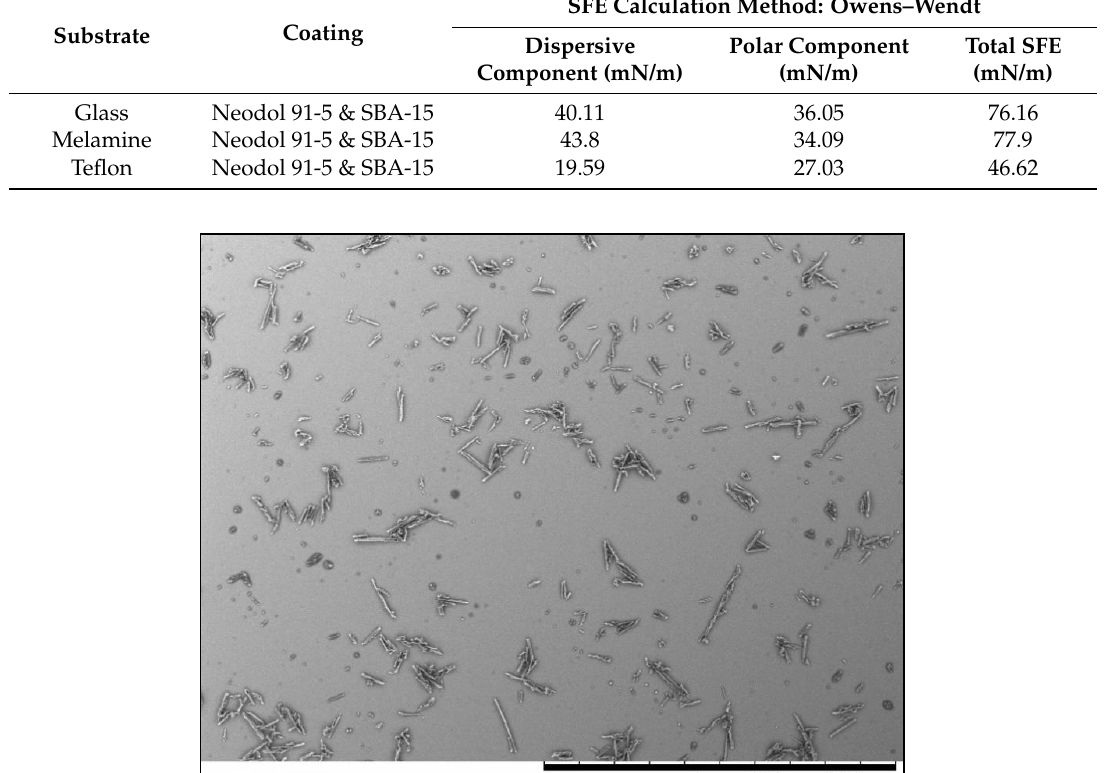
Figure 5. Glass substrate after the modification by the Neodol 91-5 and the SBA-15 solution. Colloids Interfaces 2019 , 3 , 12